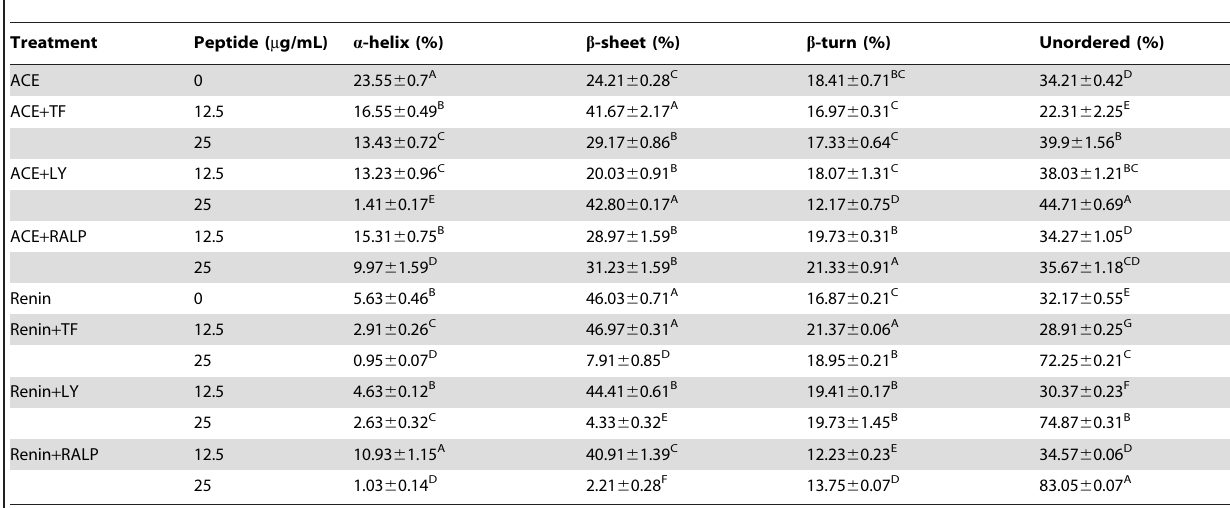
Table 3. The estimated secondary structure composition of enzyme and enzyme-peptide complex.